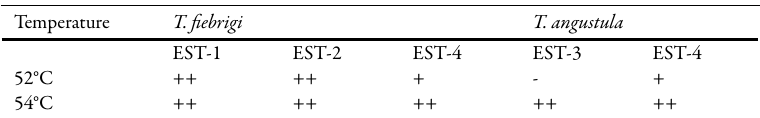
2. Inhibition patterns of esterases in Tetragonisca fiebrigi and Tetragonisca angustula at 52 °C and 54 °C. (++) total inhibition, (+) partial inhibition, (-) no